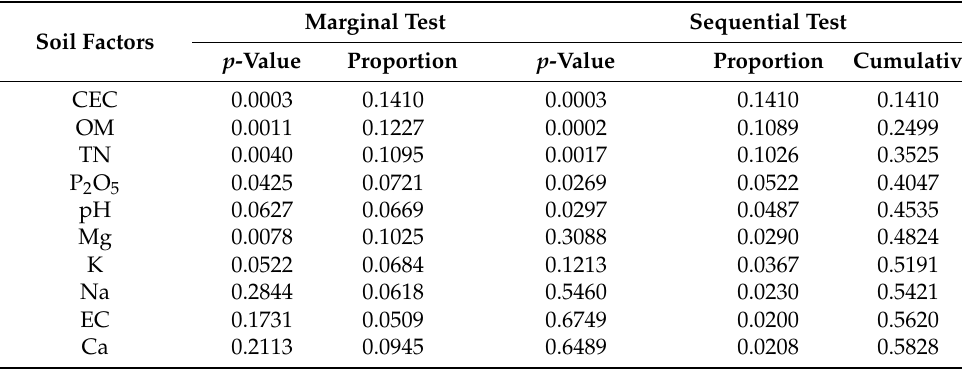
Figure 3. Principal coordinate analysis based on Bray–Curtis dissimilarity matrix for the bacterial community generated using themothur platform. Table 3. Marginal and sequential tests of DISTLM on the relation of soil factors variables to the bacterial community of soil